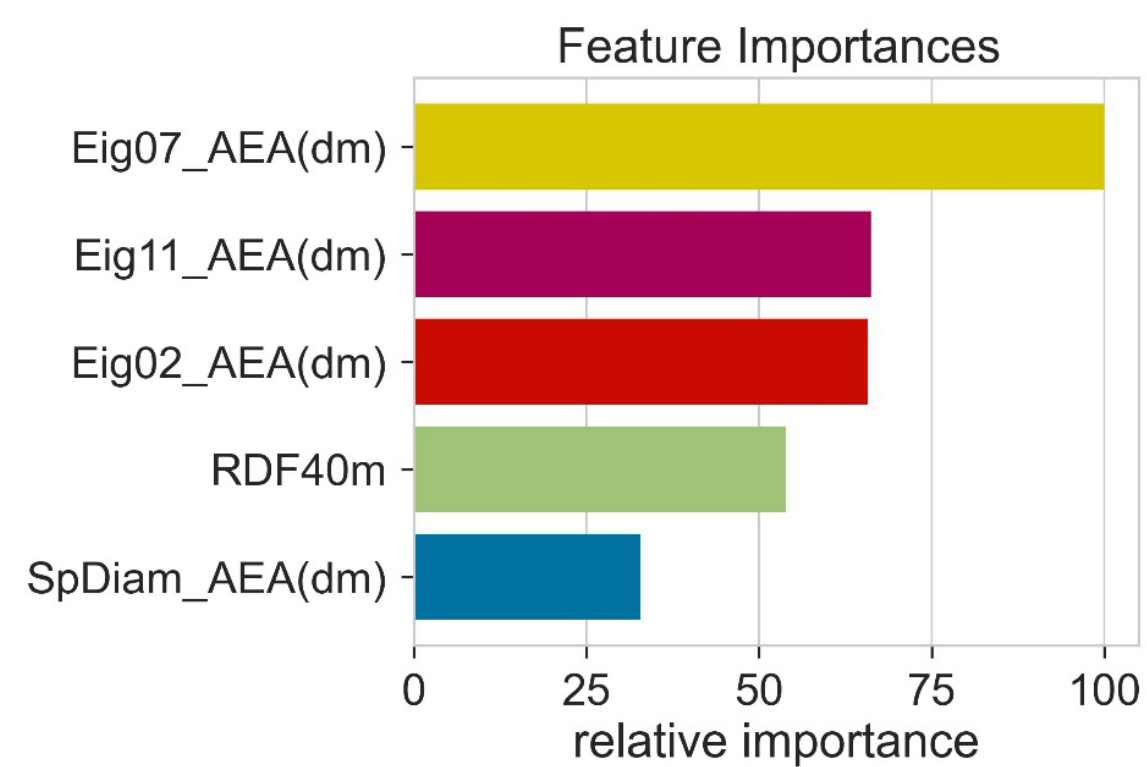
Figure 5. The relative importance of various features in machine learning models.